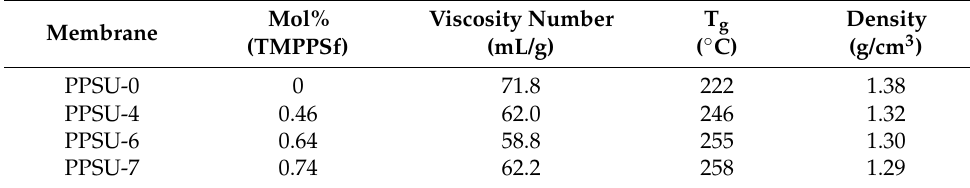
Table 1. Physical properties of